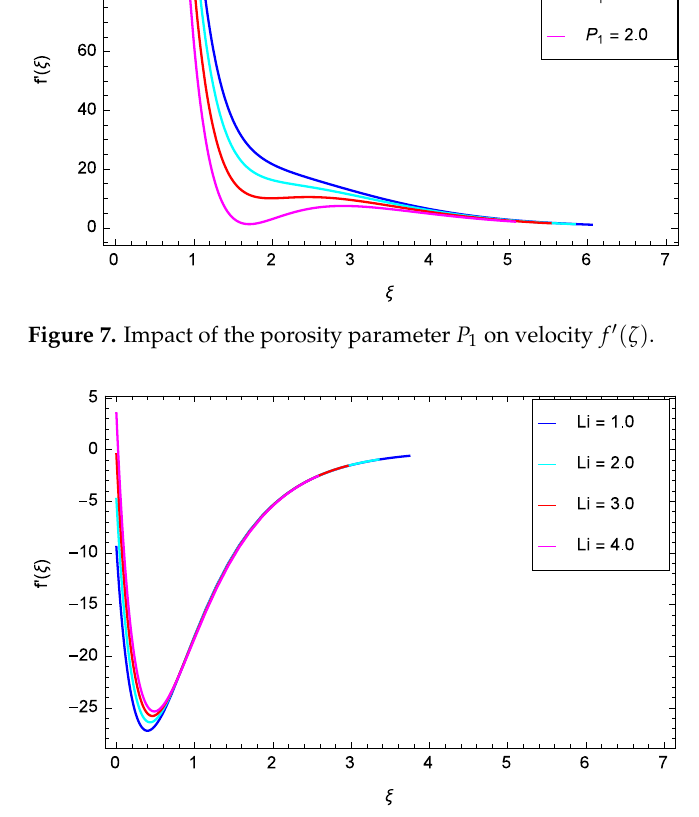
Figure 8. Impact of the local inertia parameter Li on velocity f (cid:48) ( ζ )